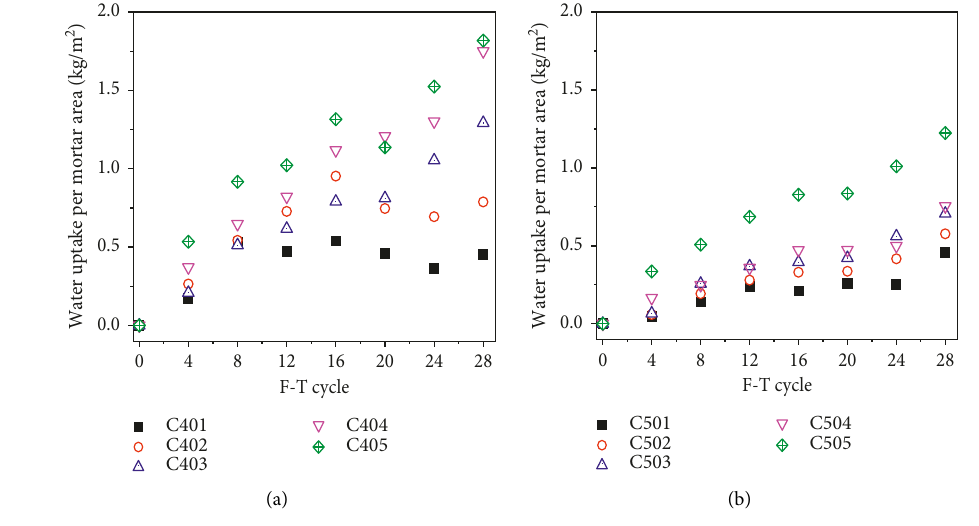
Figure 9: Water uptake per mortar area at 90d curing age.